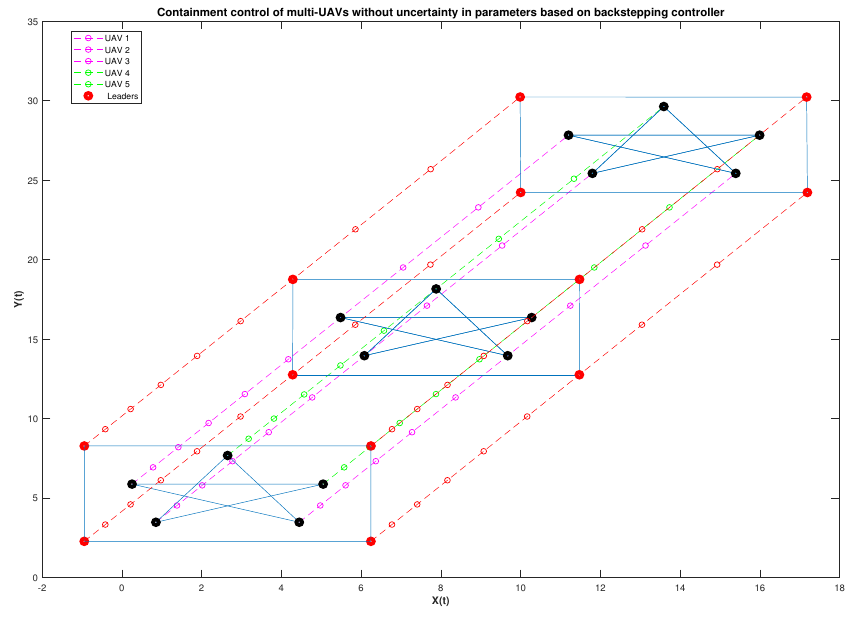
Figure 8. Map of UAVs containment based on backstepping control without parameters